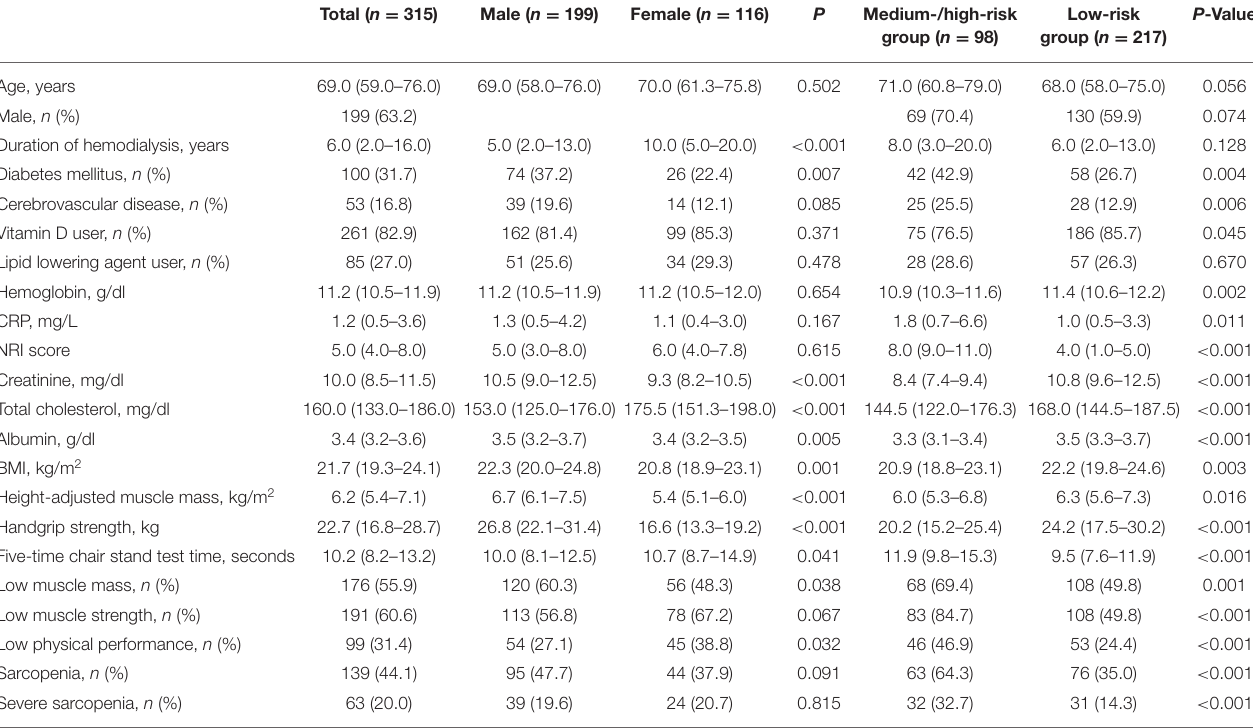
TABLE 2 | Clinical characteristics of patients ( n = 315) stratified by gender and nutritional status assessed by NRI. Total ( n =